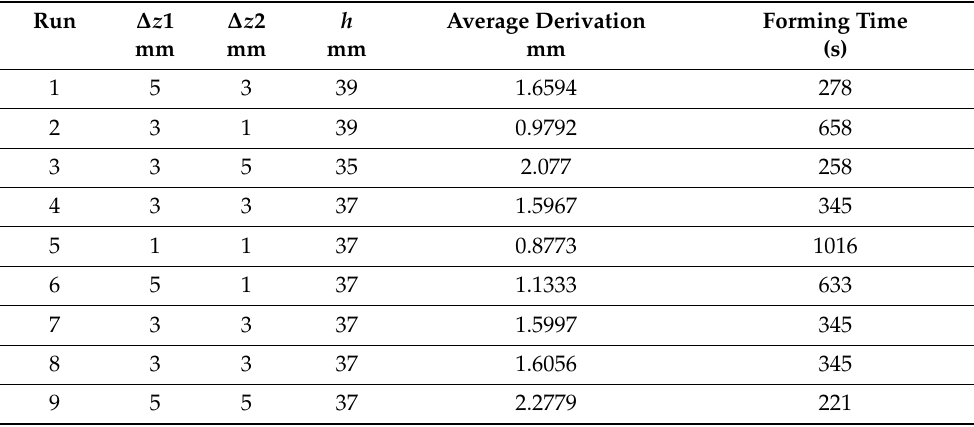
Table 2. Box–Behnken design parameters with calculated average deviation and forming